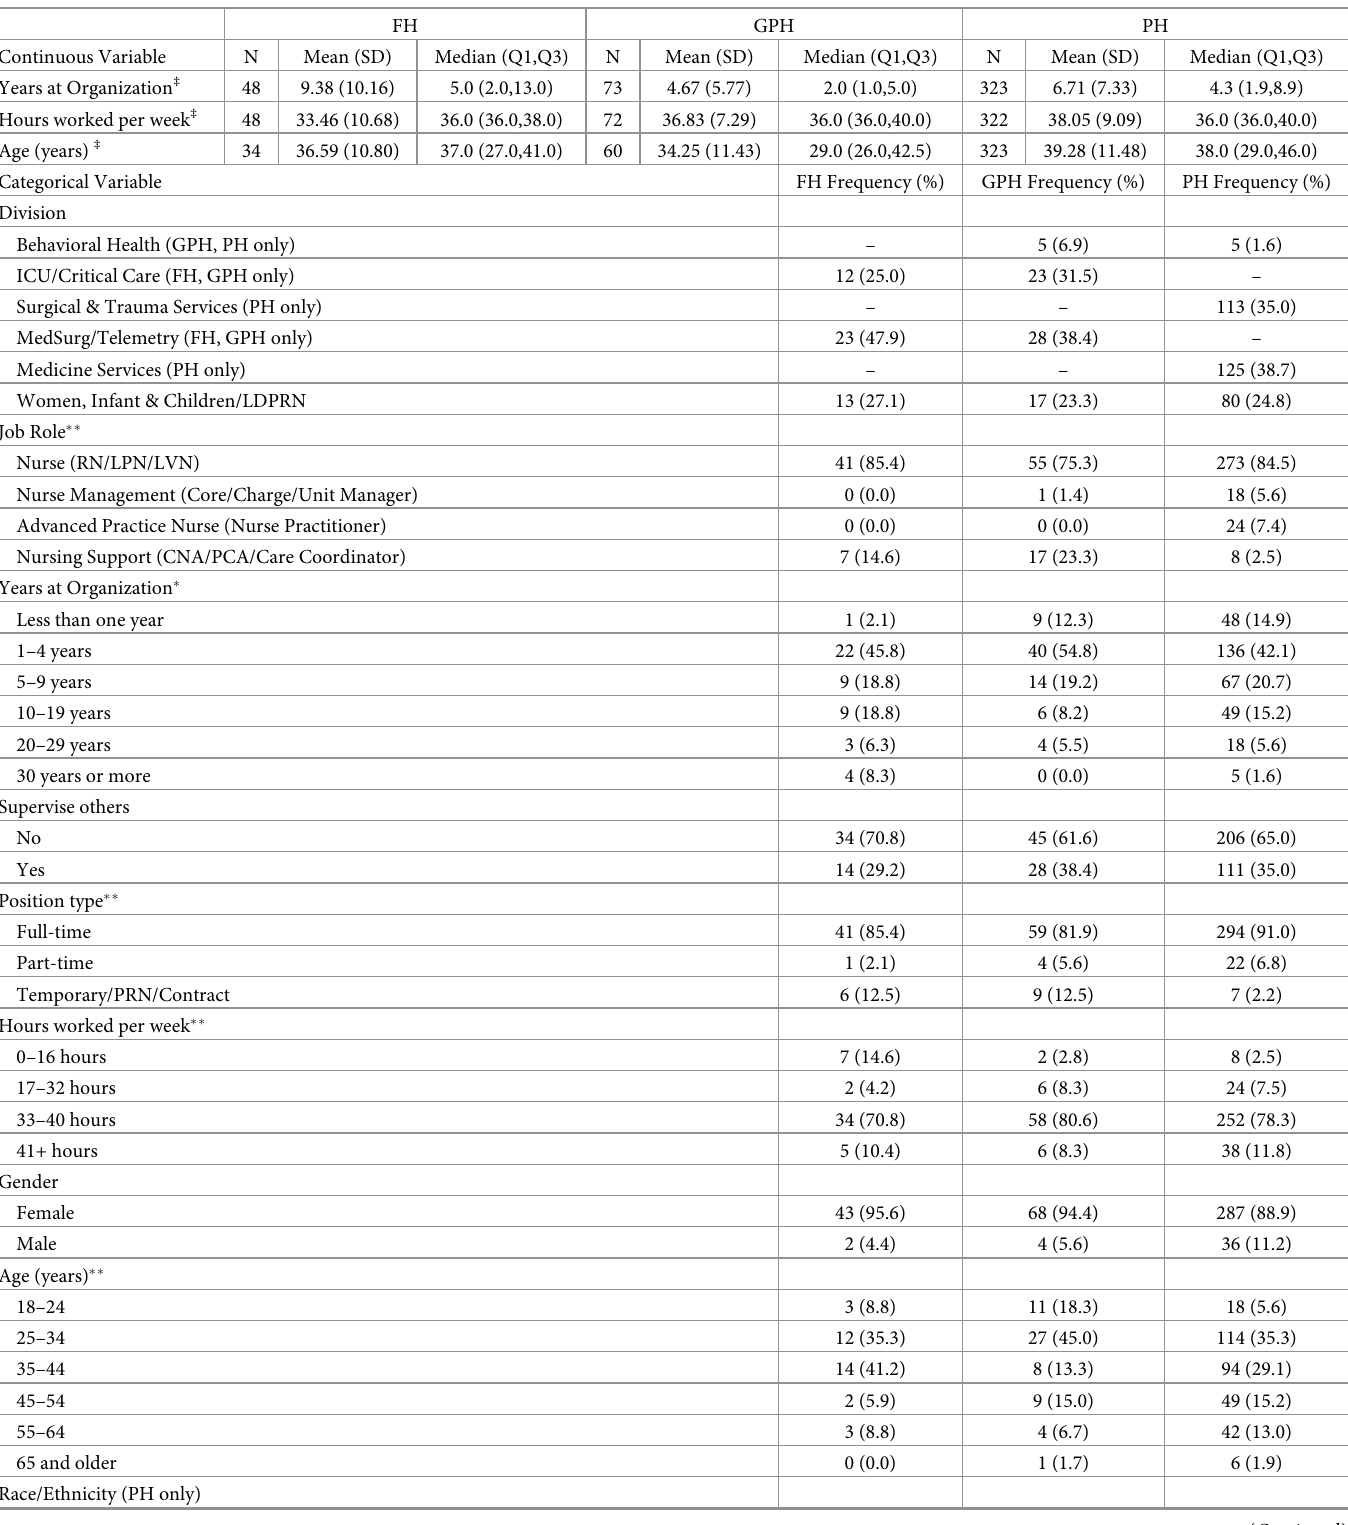
Table 3. Phase 1 continuous participant demographics by